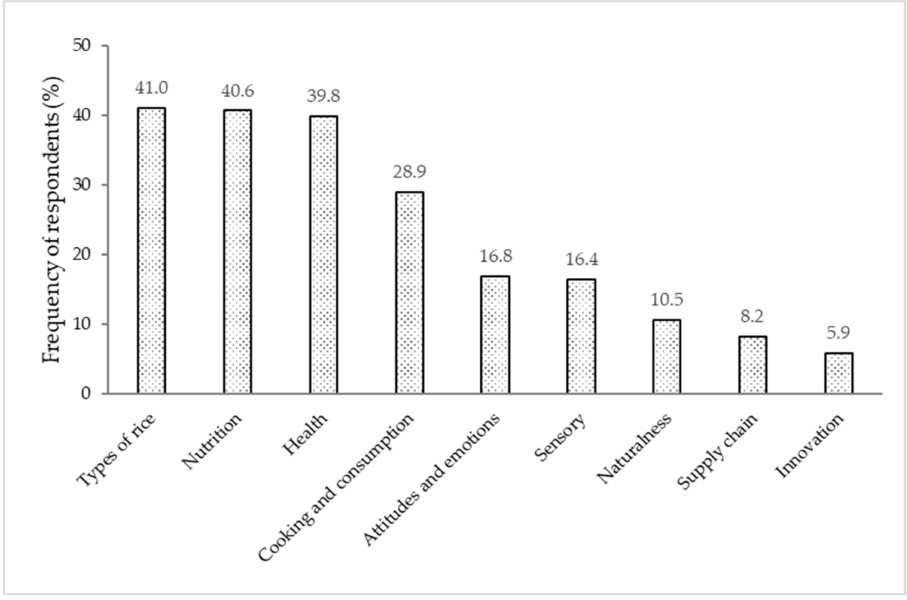
Figure 3. Frequency of respondents (%) describing words according to the dimensions for the “rice with low glycaemic index”